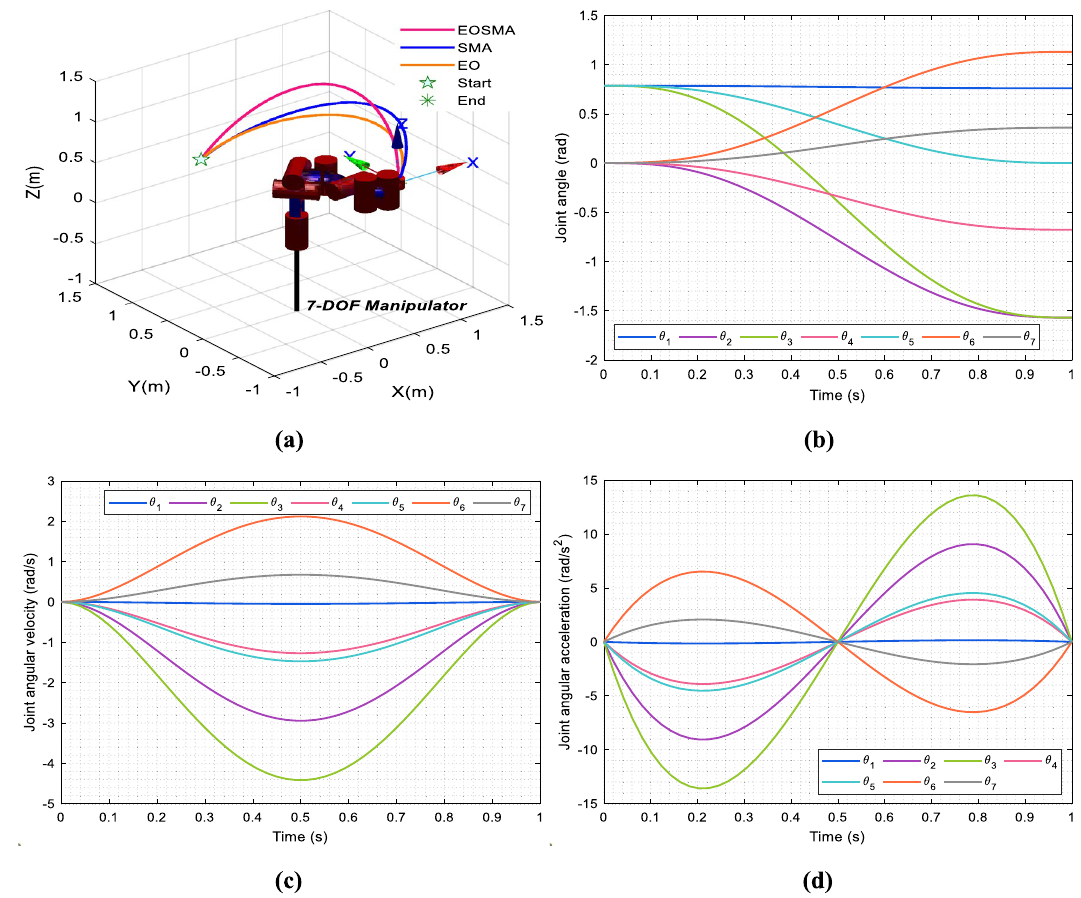
Figure 20. Simulation test results. ( a ) The trajectory of end-effector of the 7-DOF manipulator. ( b ) Curves of joint angle with time. ( c ) Curves of joint angular velocity with time. ( d ) Curves of joint angular acceleration with